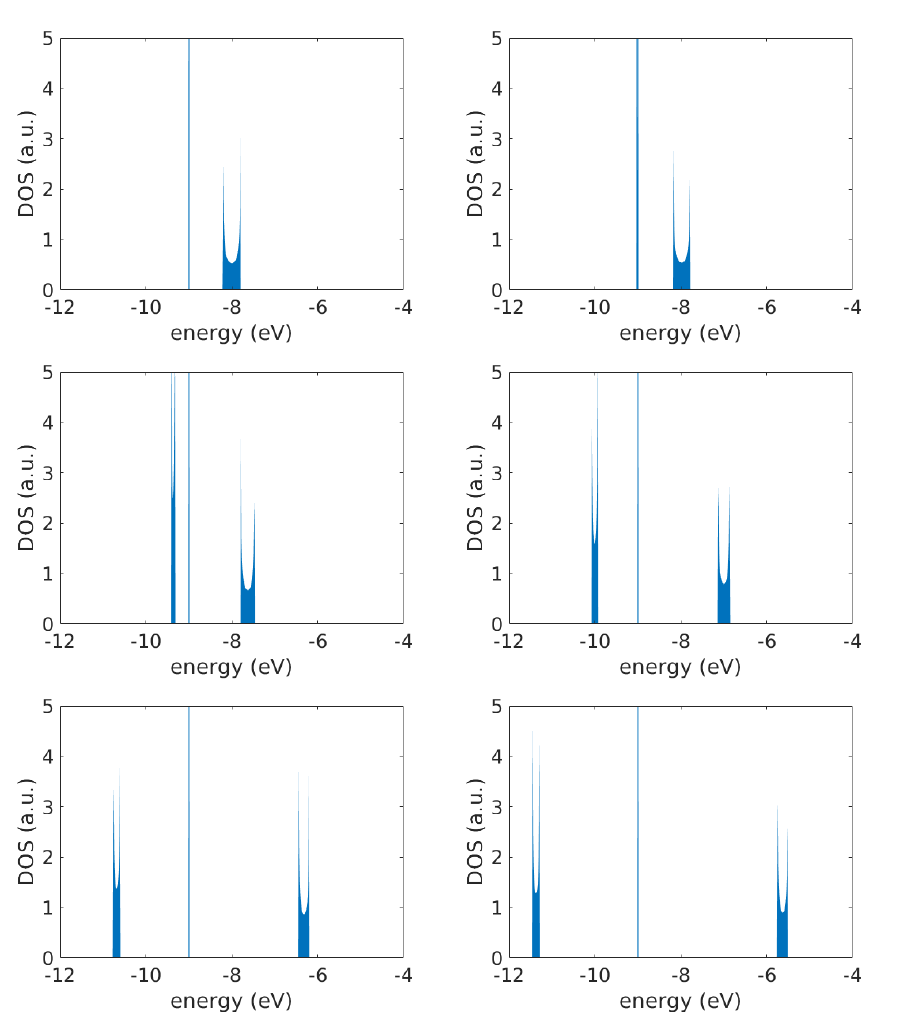
Figure 3. FWM DOS for a G... homopolymer with N = 2000 for t S = 0.0, 0.1, 0.5, 1.0, 1.5, and 2.0 eV (from top left to bottom right). In an infinite system, there are van Hove singularities at the subband edges, and the central degenerate band at E S becomes infinitely